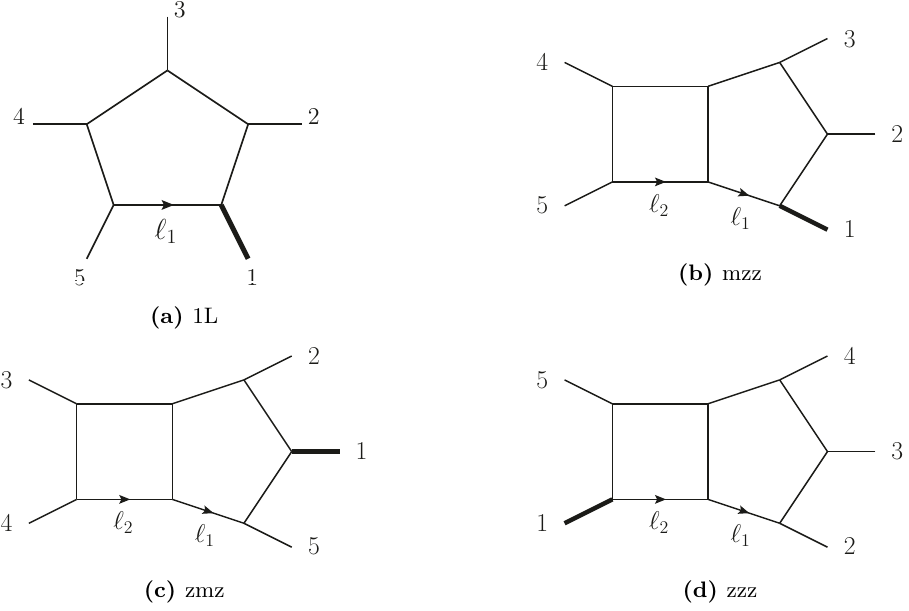
Figure 1. Representative diagrams for the planar five-particle integral families with a single external massive leg at one and two loops. The arrows denote momentum flow. The thick line represents the massive external